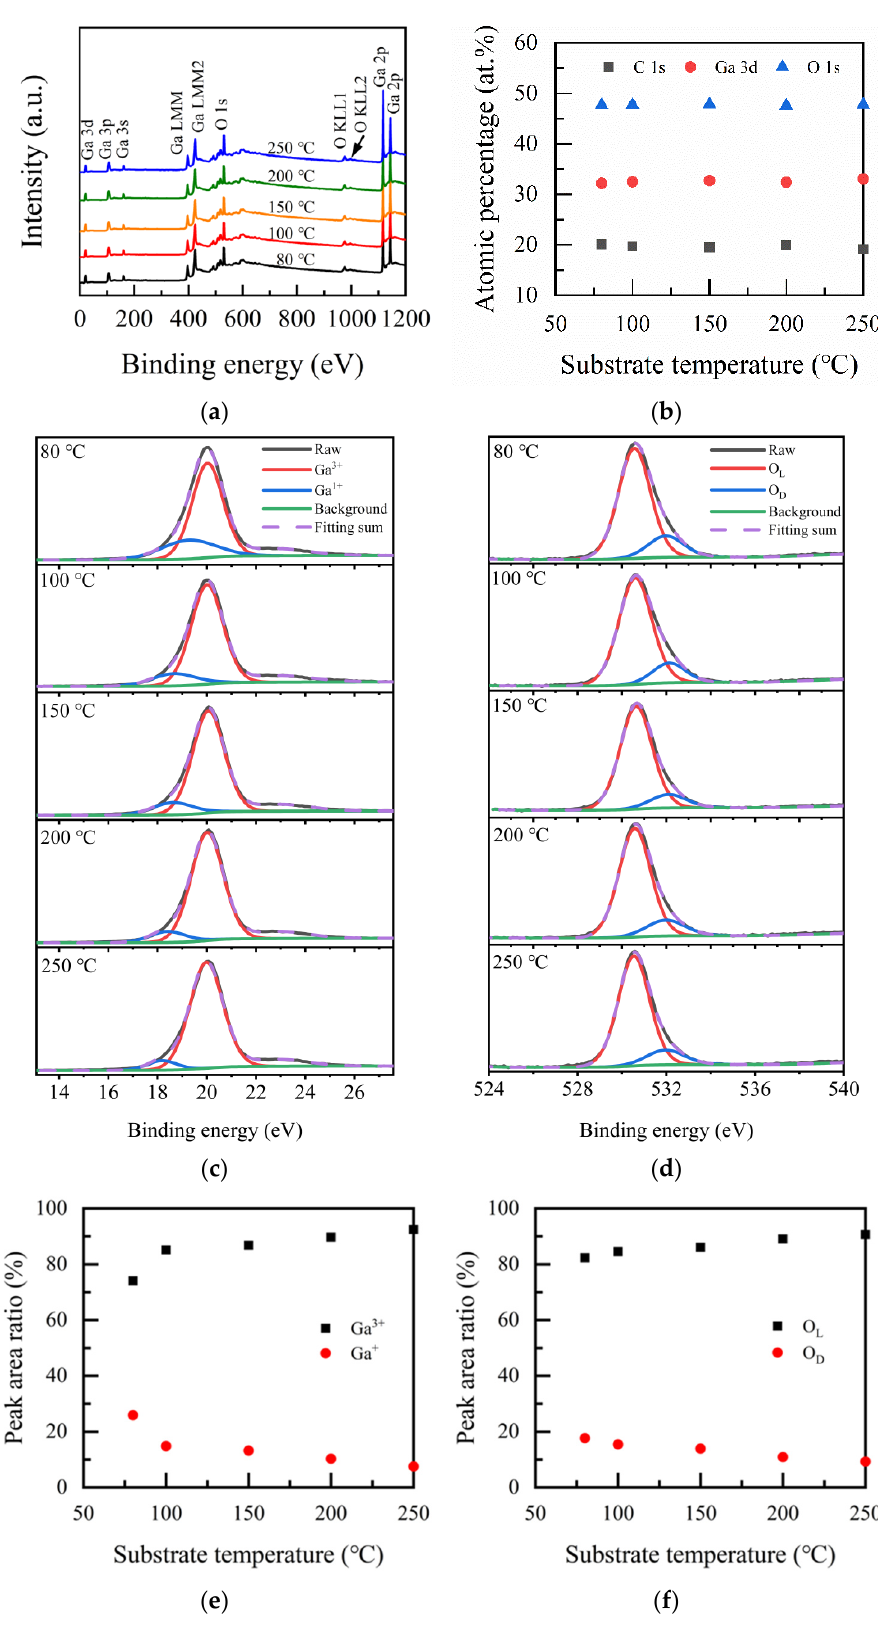
Figure 3. ( a ) XPS spectra of the Ga 2 O 3 films deposited at different deposited temperatures. ( b ) Atomic ratio of the Ga 2 O 3 films vs. substrate temperature. The high-resolution spectra of ( c ) Ga 3d; ( d ) O 1s; peak area ratios of ( e ) Ga 3+ and Ga + ( f ) O L and O D .